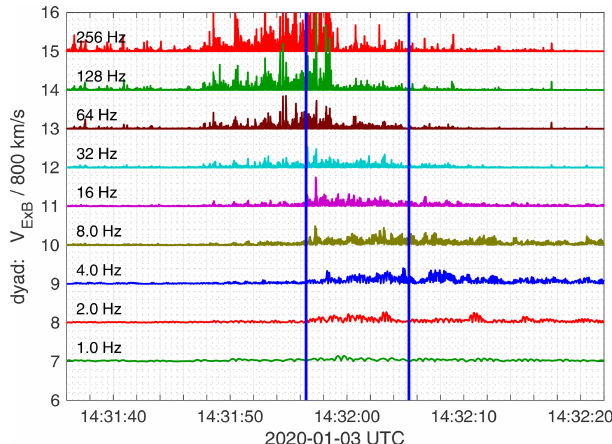
Figure 3. Multiresolution decomposition of the (cid:101) V E × B wave speed for the time interval of Fig. 2. It shows acceleration capacity of waves in the frequency range 1–256Hz, which can account for the measured velocities of ions shown in Fig. 2a–c. Blue vertical lines mark the shock ramp